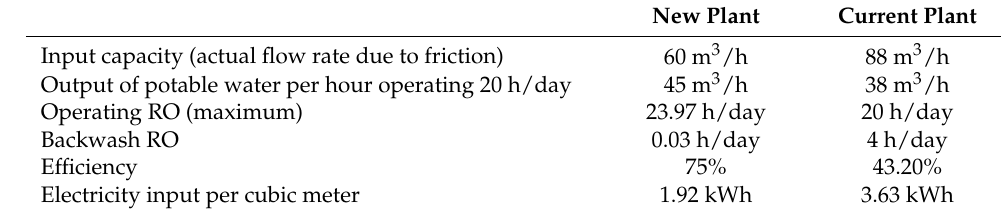
Table 1. Efficiency characteristics of the two reverse osmosis technologies.